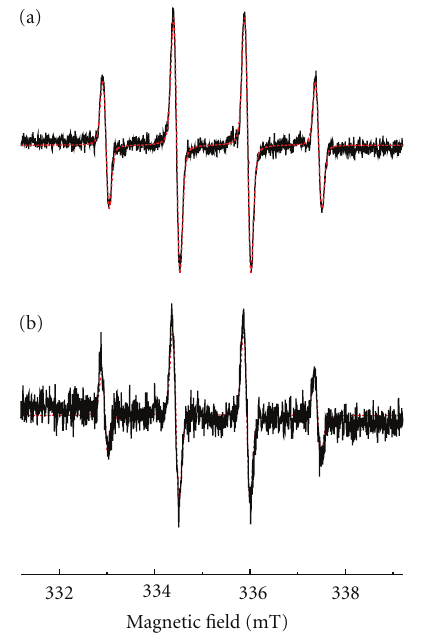
Figure 8: Experimental (solid line) and simulated (dotted line) EPR spectra of • DMPO-OH adduct obtained upon irradiation of aqueous TiT 144 ground suspensions in the presence of DMPO ( c TiT 144 = 0 . 875gl − 1 , c 0,DMPO = 0 . 025moll − 1 ): (a) Pyrex ( λ > 300nm), • DMPO-OH concentration of 1.1 μ moll − 1 was monitored during 660 seconds of irradiation; (b) GG 435 filter ( λ > 435 nm), • DMPO-OH concentration of 0.3 μ moll − 1 was measured during 1350 seconds of irradiation.